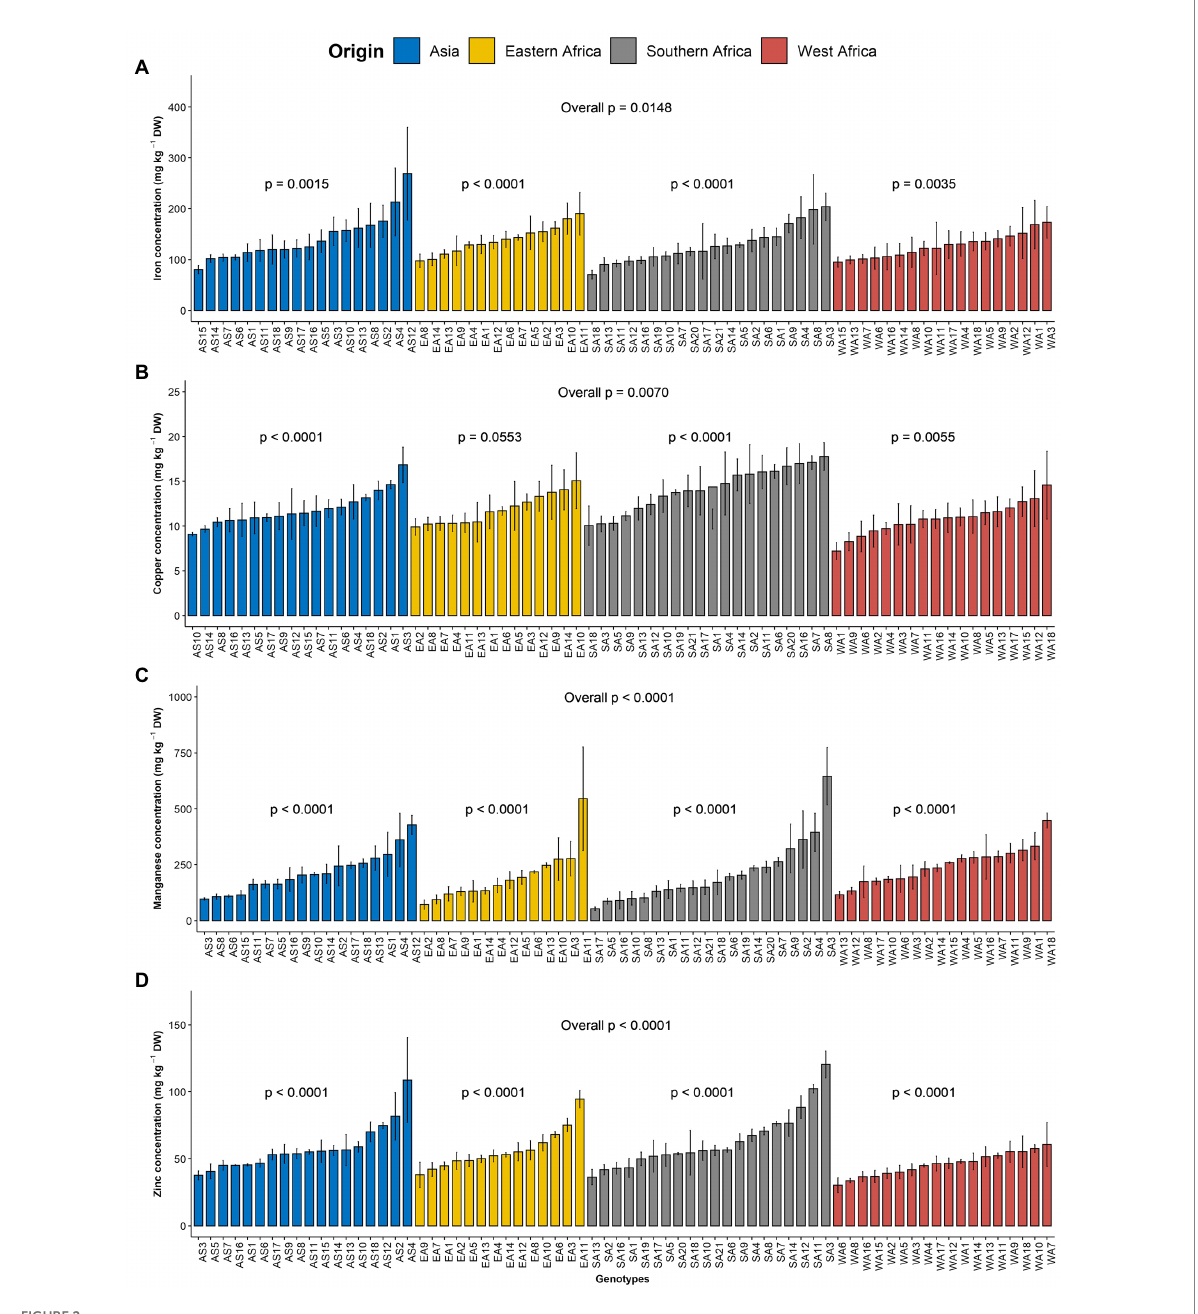
FIGURE 2 Variation in leaf microelements content among 70 advanced lines of G. gynandra evaluated across years (2020 and 2021). (A) Iron content; (B) Copper content; (C) Manganese content and (D) Zinc content. Bar plots are means and error bars represent standard errors across years ( n =